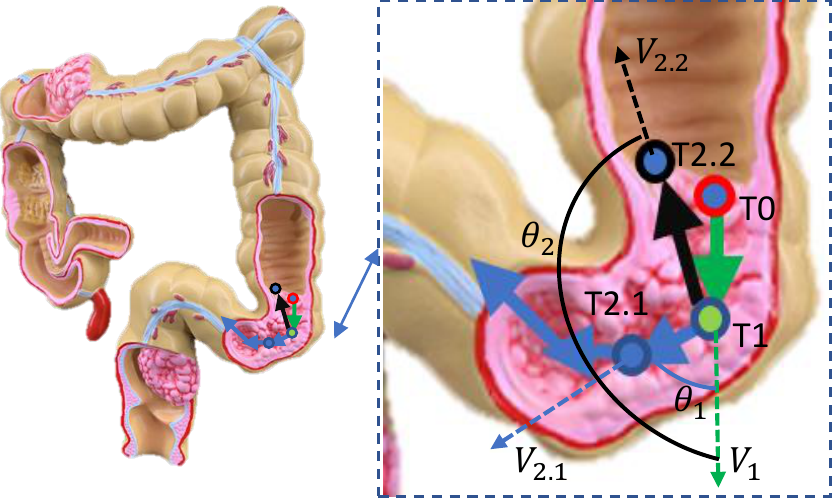
Figure 4. The state of the capsule robot moving in the corner. P shows the current position of the capsule robot, and V 1 reveals the robot’s movement at the last moment. The robot may move in the direction of V 2.1 or V 2.2 at the next moment, and the angle was formed by the adjacent moments θ 1 and θ 2 ,